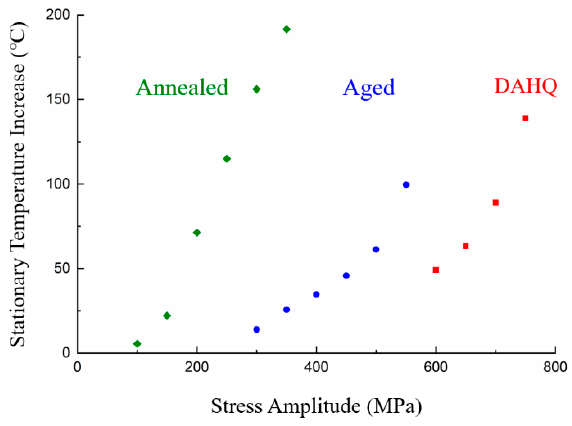
Figure 7. Stationary temperature increase of Inconel 718 ( R = − 1, f = 20 kHz).